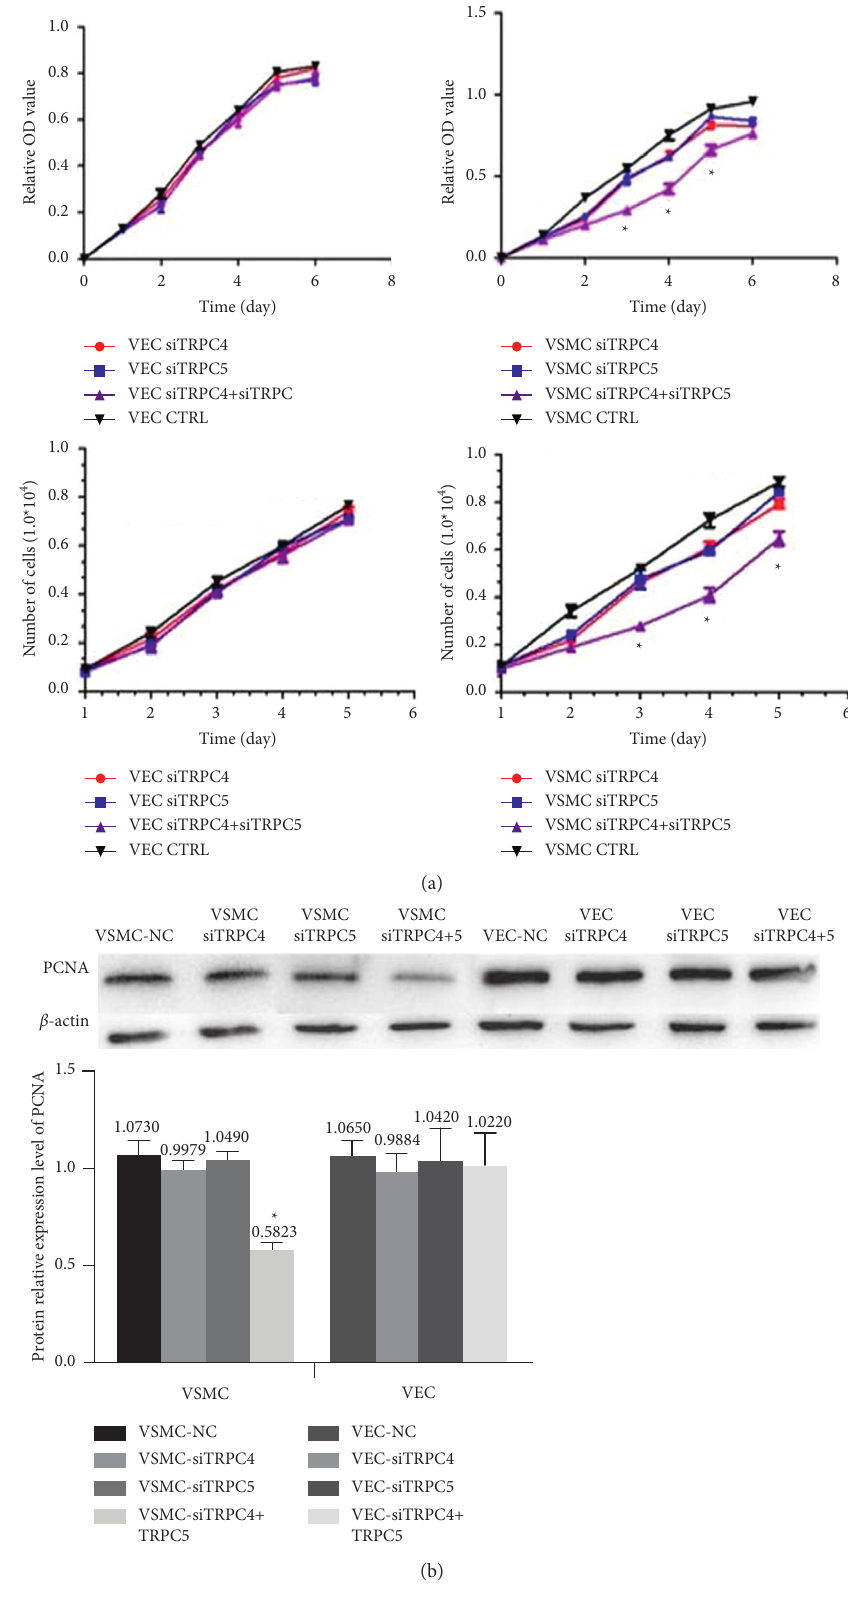
Figure 3: (a) The effects of silencing TRPC4 and TRPC5 on VEC and VSMC proliferation assessed by CCK-8 analysis and viable cell counting. ∗ p < 0 . 05 vs. VSMC-CTRL, VSMC siTRPC4, and VSMC siTRPC5. ∗ ∗ p < 0 . 01. (b) Western blotting analysis of PCNA protein expression. For both VSMCs and VECs, TRPC4, TRPC5, and combined TRPC4 +5 interference groups were tested, and the results were compared with the NC group. Data are presented as the means+SEM. N � 12. ∗ p < 0 . 05 vs.